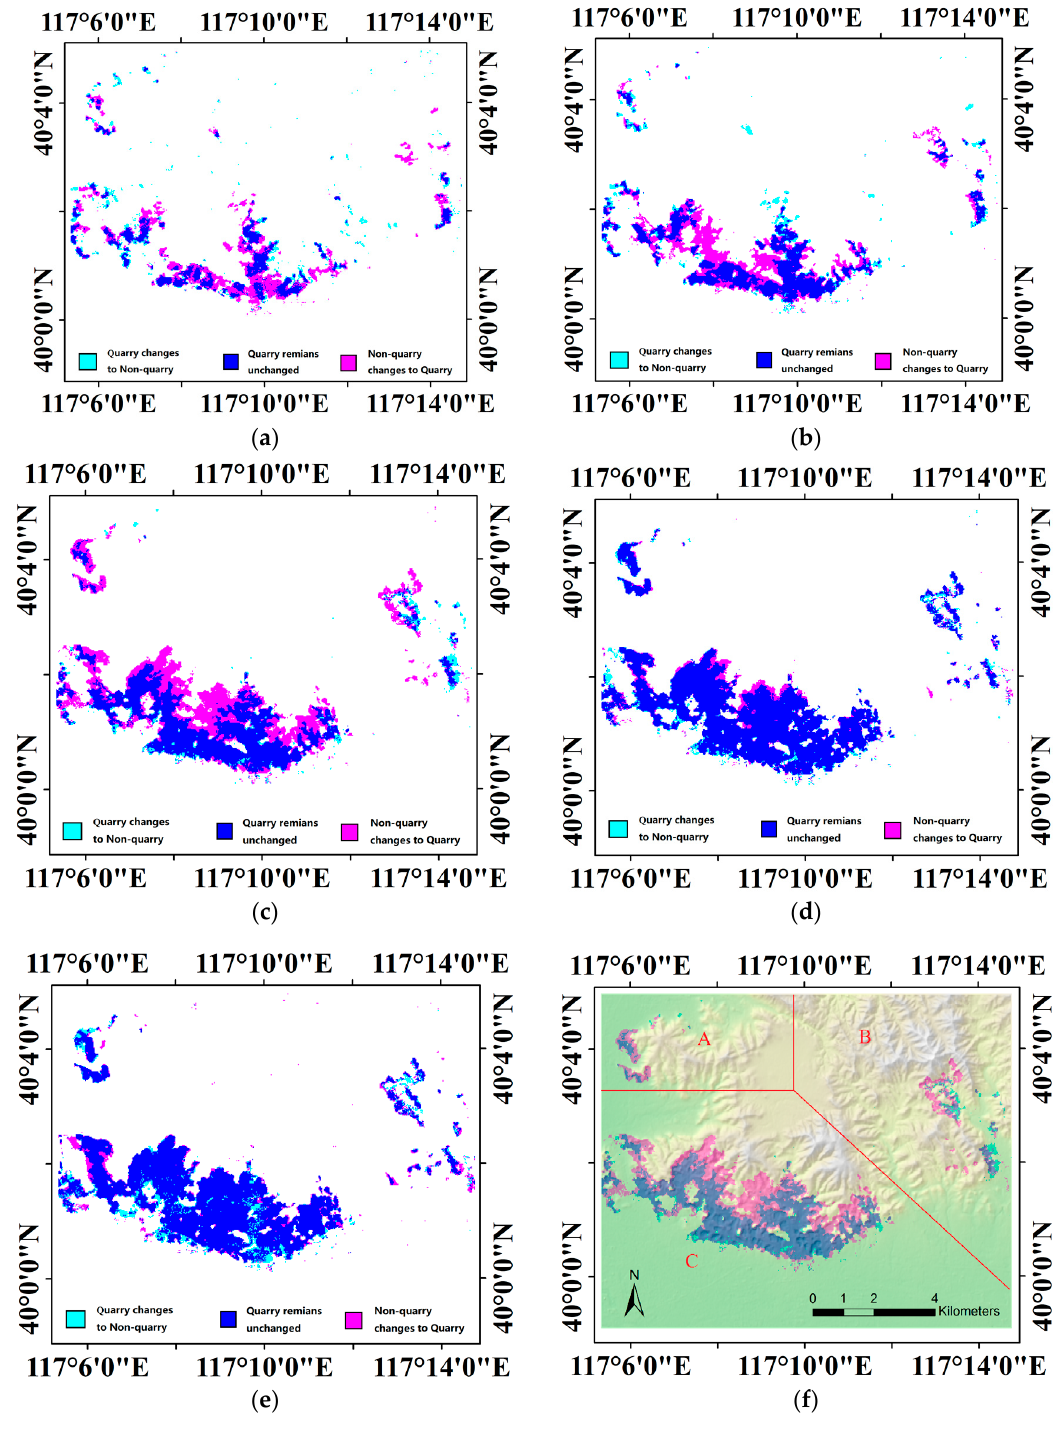
Figure 7. Change maps of quarry region in five periods where the blue regions mean no change happened, red regions mean quarry extension, and cyan regions mean quarry recovery. ( a ) 1984–1992; ( b ) 1992–2002; ( c ) 2002–2010; ( d ) 2013–2016; ( e ) 2010–2013; ( f ) Three continuous quarry regions.